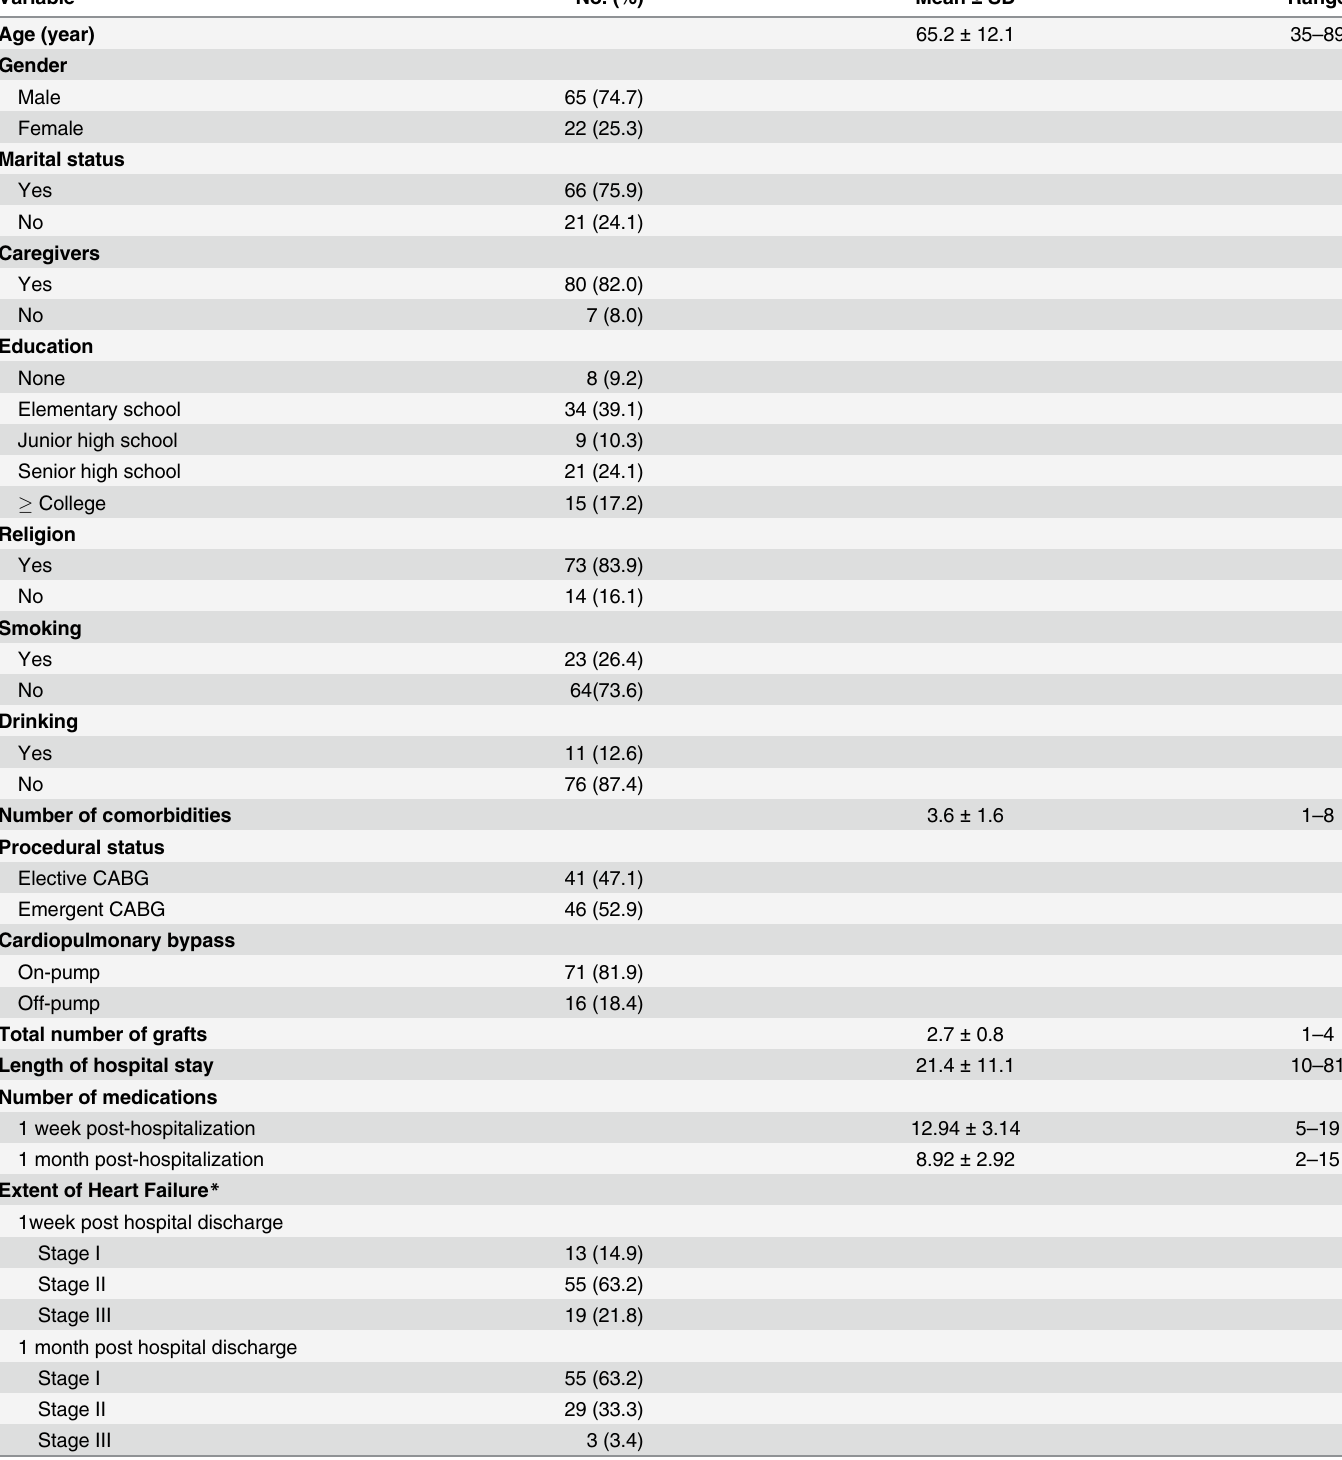
Table 1. Participant demographics ( n =